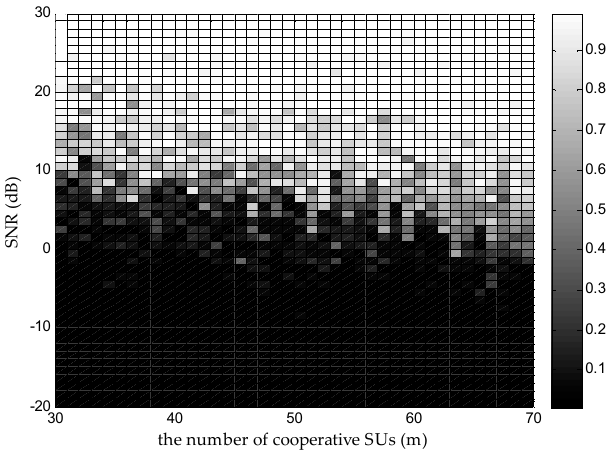
P under different SNR levels when 6 N and . r